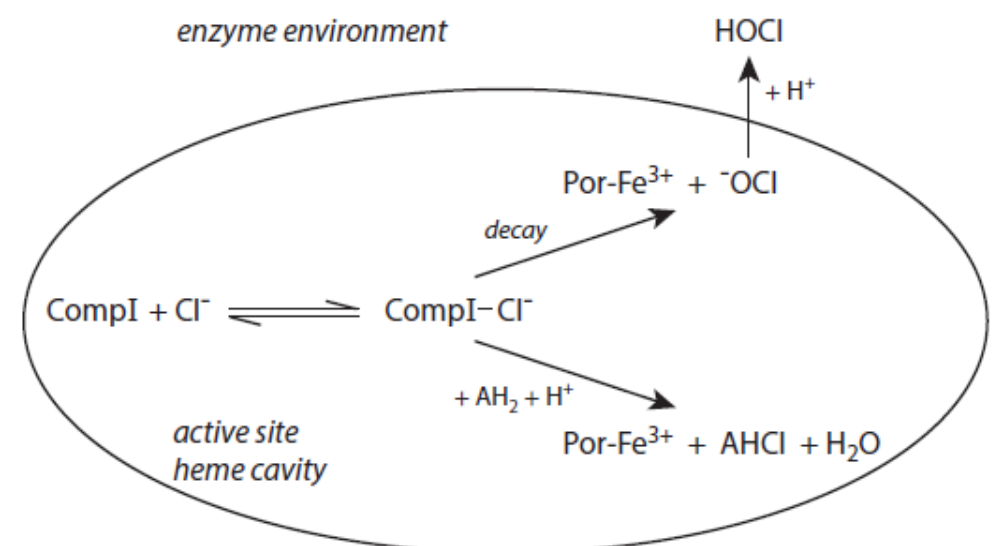
Figure 1. The role of the chloride–Compound I complex (CompI-Cl − ) in chlorination reactions mediated by MPO according to [44,45]. Explanations are given in the text. CompI denotes Compound I. AH 2 represents a substrate that binds near the heme pocket. AHCl is the resulting chlorinated substrate.